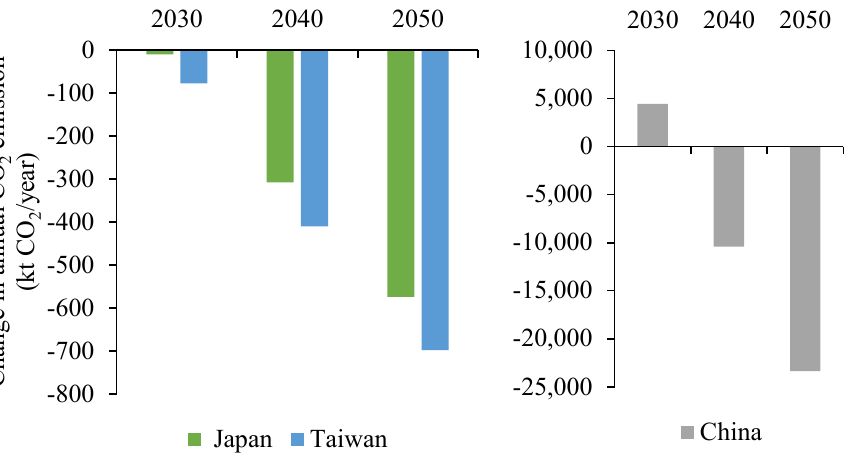
Figure 22. Total combined change in annual CO 2 emission after electrification of all seven studied textile wet processes.